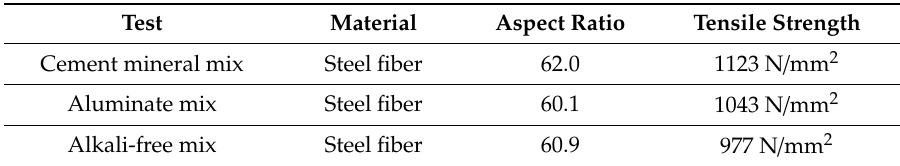
Table 3. Physical properties of the steel fiber.